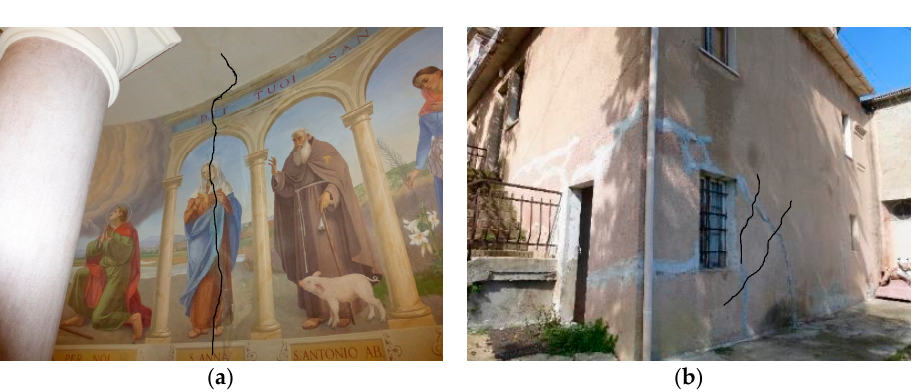
( c ) Figure 2. Example of a damage survey of a church struck by the 2016 seismic event: ( a ) vertical crack in the apse in correspondence to a perpendicular wall situated at the back; ( b ) diagonal cracks in the sacristy corner; and ( c ) the church survey form reporting the volumetric stratigraphy and the crack pattern sketches. 4. The Effect of an Incorrect Interpretation of Built Heritage Damage after a Seismic Event Some examples of incorrect interpretation of the damage in historic buildings are reported here. All strengthening intervention against seism should take into account the history and constructive evolution of the building, with all the modifications made over the centuries, right up to the recent ones. As already reported above, the presence of such discontinuities makes a historic building much weaker than a similar one, but homogenous and compact, and often concurs to add irregularities both in the plane and in the height, as shown in Figures 1 and 2. Any application of provisional strengthening systems should also take into account pre-existing weak points, with the discontinuities and constructive historic evolution, in addition to the observed damages and the current damage mechanisms revealed. The aim is to avoid wrong, heavy, or useless invasive intervention on architectural heritage sites, as observed in the historic centre of L’Aquila after the 2009 earthquake. Massive safety intervention is certainly able to avoid collapses during the